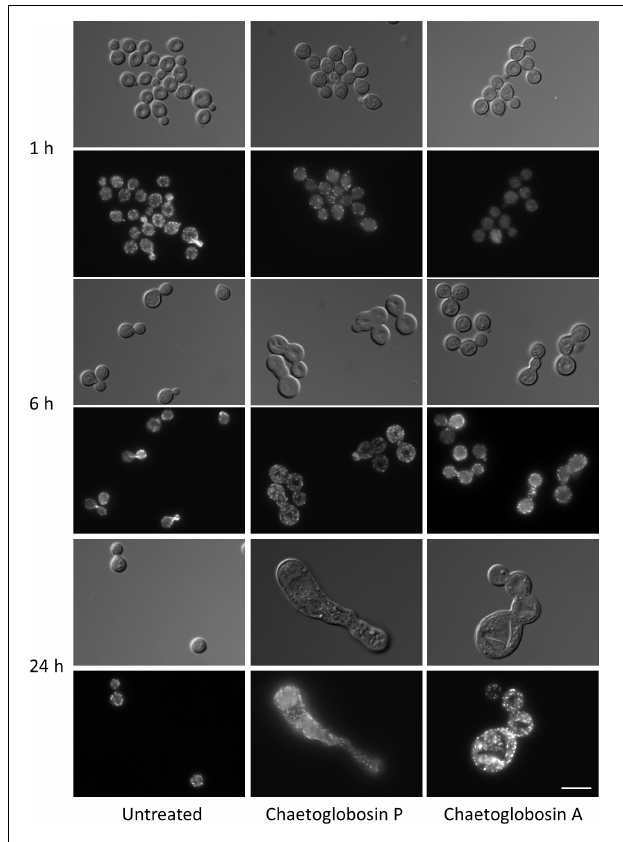
FIGURE 3 | Effects of chaetoglobosins P and A on morphology and actin localization in cells of C. neoformans . Wild-type strain H99 was incubated overnight in YPD at 30 ◦ C, diluted to OD 0.2 in YPD medium, incubated 2 h at 30 ◦ C, then incubated at 37 ◦ C with the indicated drug. At the indicated time, cells were formaldehyde-fixed, permeabilized, and incubated with TRITC-conjugated phalloidin which binds to actin structures. Bar = 10 µ m.